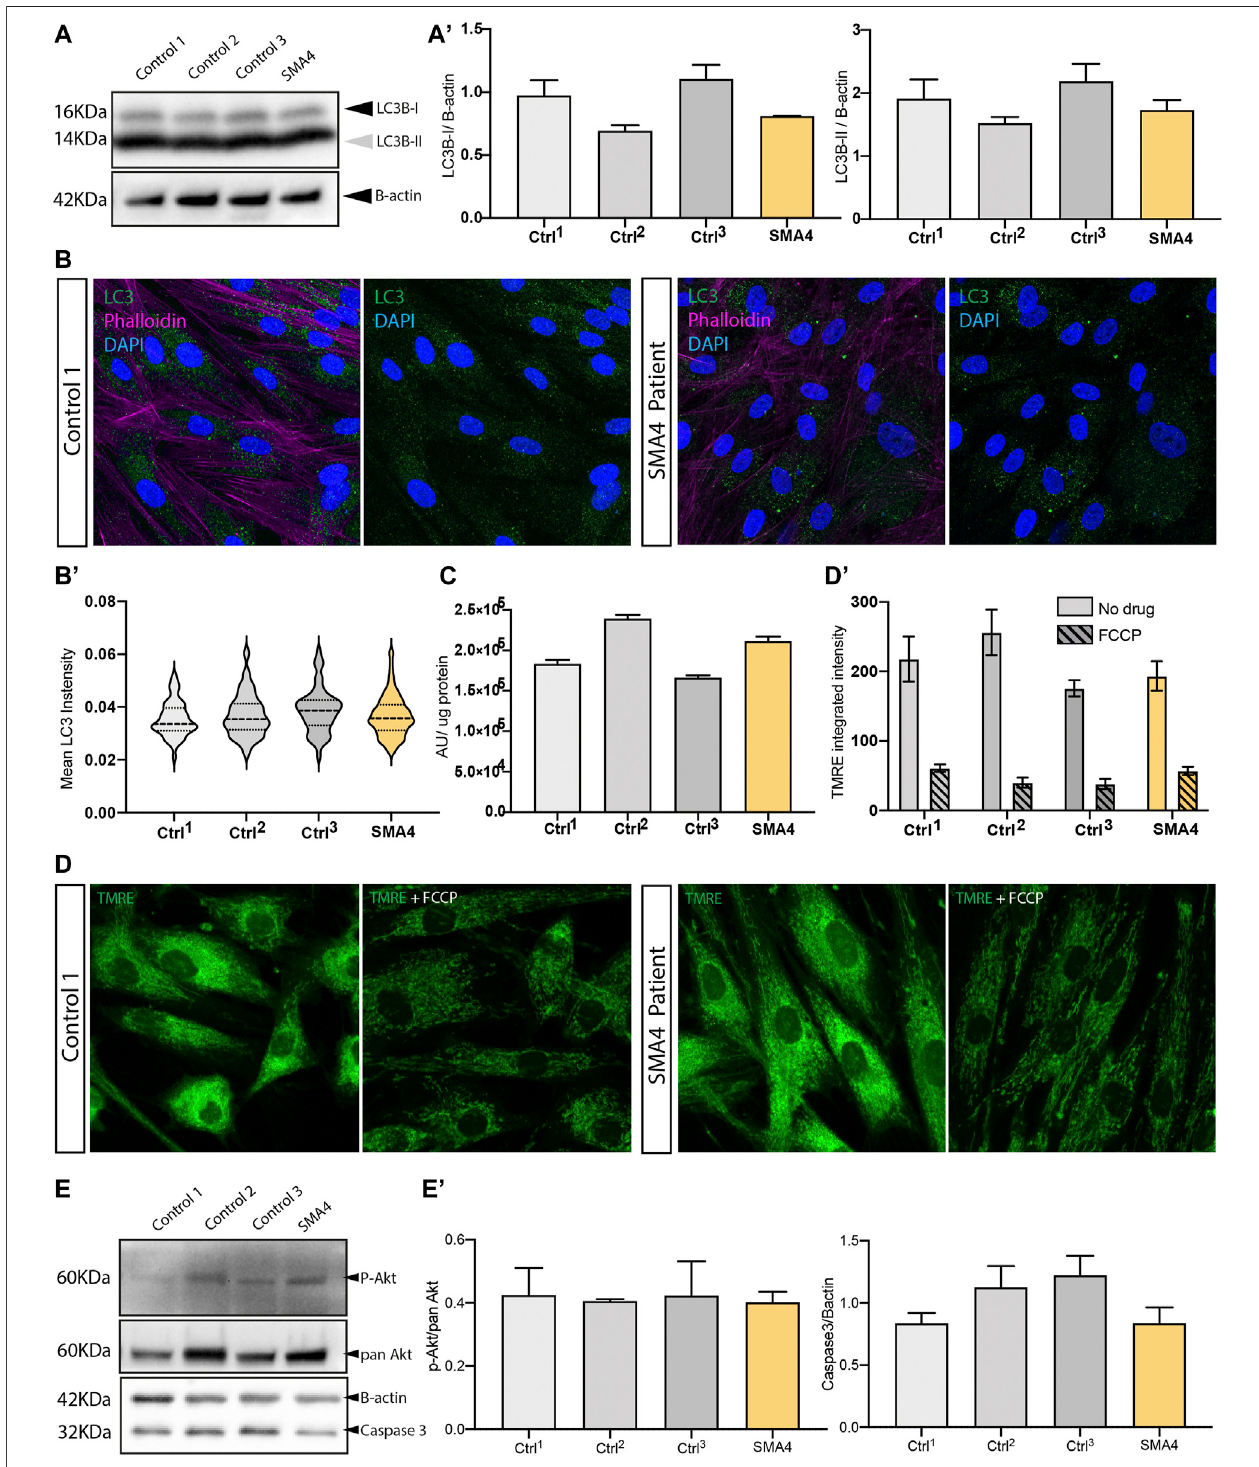
FIGURE 4 | Effect of the CAPN1 compound heterozygous mutation on intracellular pathways affected in spinal muscular atrophy. (A) Protein levels of the autophagy marker LC3B (LC3B-II, 14 KDa and LC3B-I, 16 KDa) determined by western blot analysis in lysates from SMA4 patient (proband II:2) compared to controls fi broblasts. β -actinwasusedasaloadingcontrolintheseexperiments. (A) TheexpressionofLC3BtypeI(LC3B-I)andLC3BtypeII(LC3B-II)wasdeterminedandshown in bar graphs as the mean ± SEM from 3 independent experiments. (B) Autophagy occurrence visualised by confocal microscopy using an anti-LC3B antibody (green)incellsstainedwithphalloidin(violet). (B) .Quanti fi cationoftheLC3Bcytoplasmicexpressionwithineachcell.Violinplotshowsthefulldistributionofalldatapoints